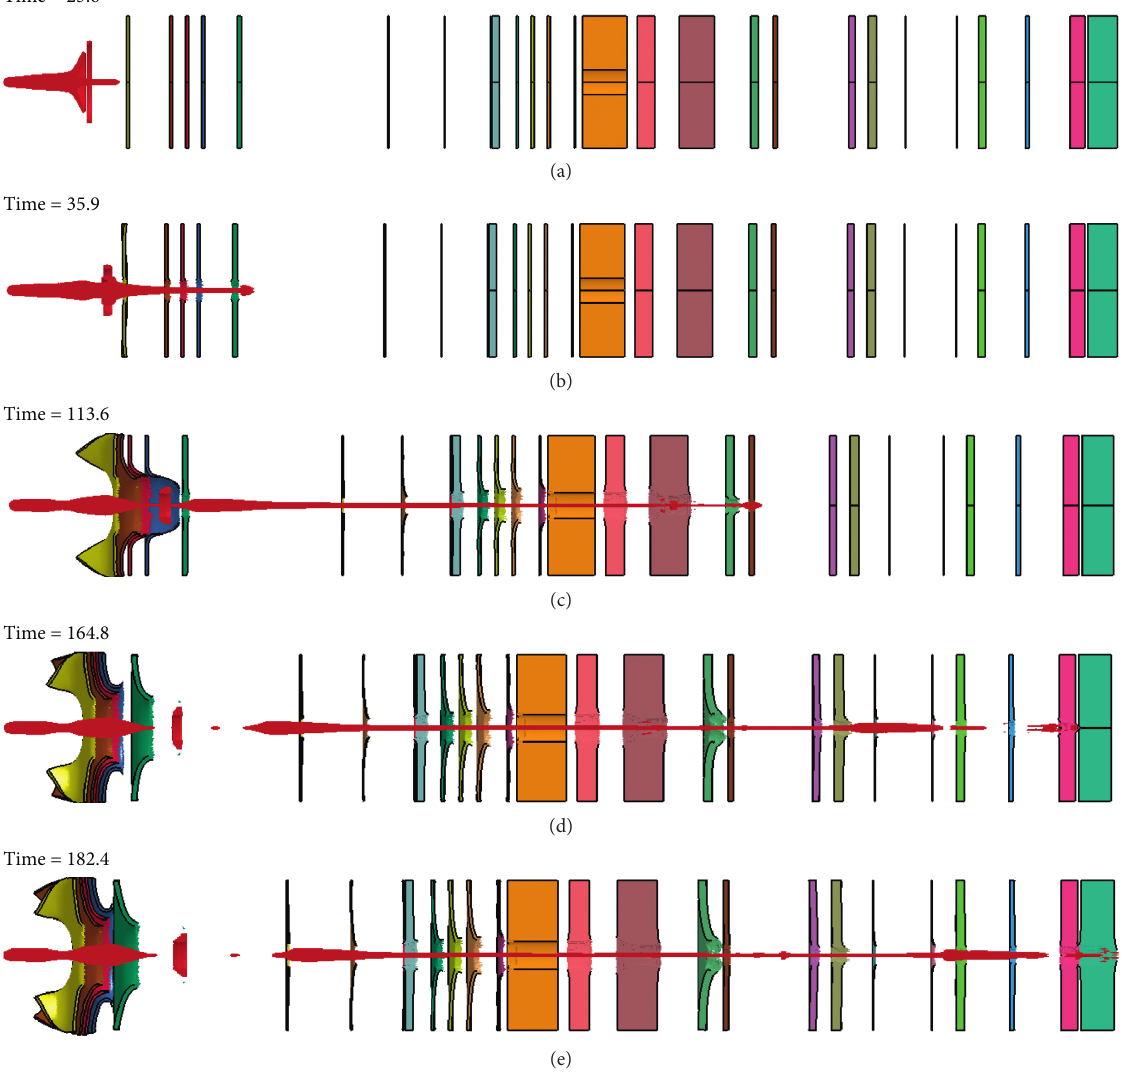
Figure 5: Penetration results of jet formed when liner material is copper: (a) the SCJ at observation point 1; (b) the SCJ at observation point 2; (c) the SCJ at observation point 3; (d) the SCJ at observation point 4; (e) the SCJ at observation point 5.